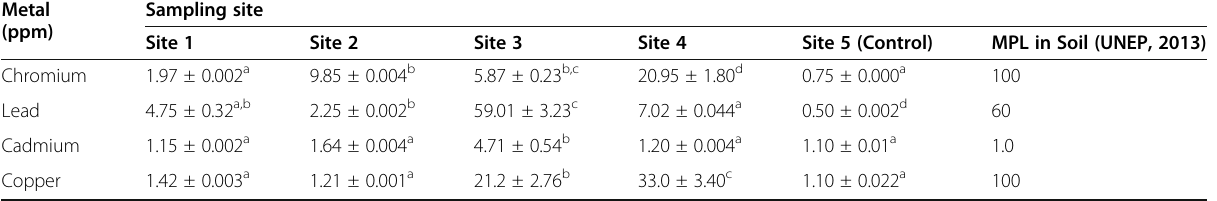
Table 2 Heavy metal content of soil obtained from soil of local mining sites of Zamfara State, Nigeria Metal